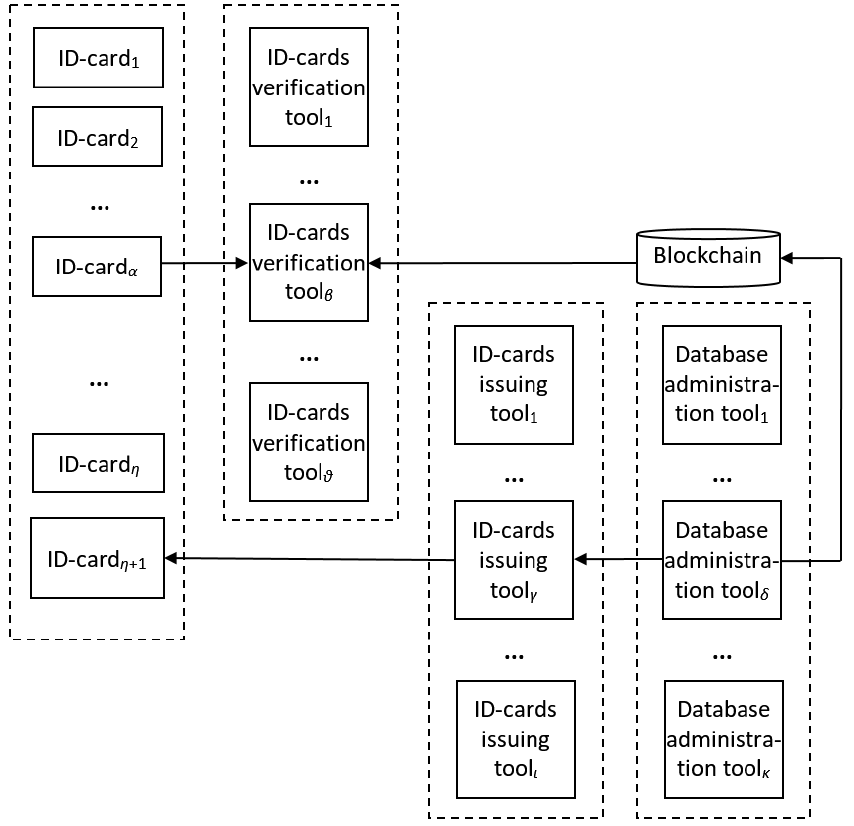
Figure 2. Detailed schematic representation of ID-card verification and issuing